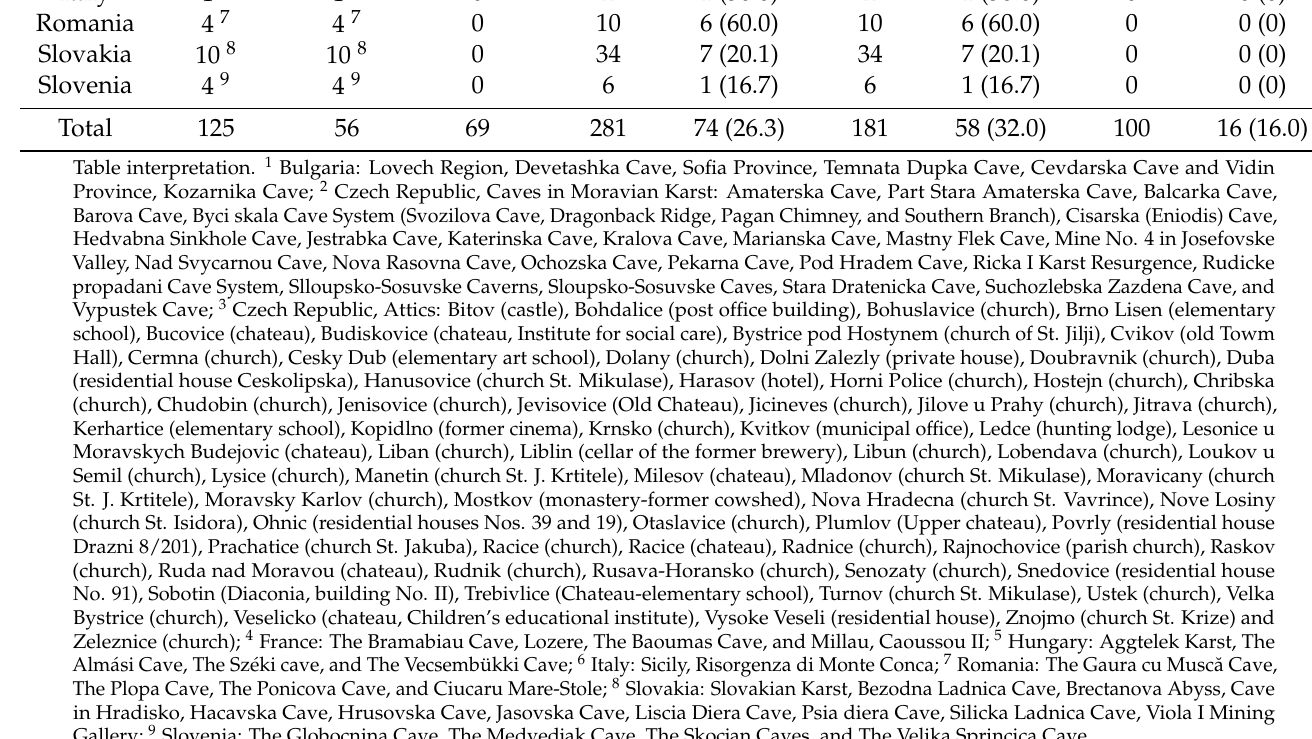
Table 1. Examined guano samples from caves and attics from nine countries. Country Locality Nos. Bat Guano Sample Nos.